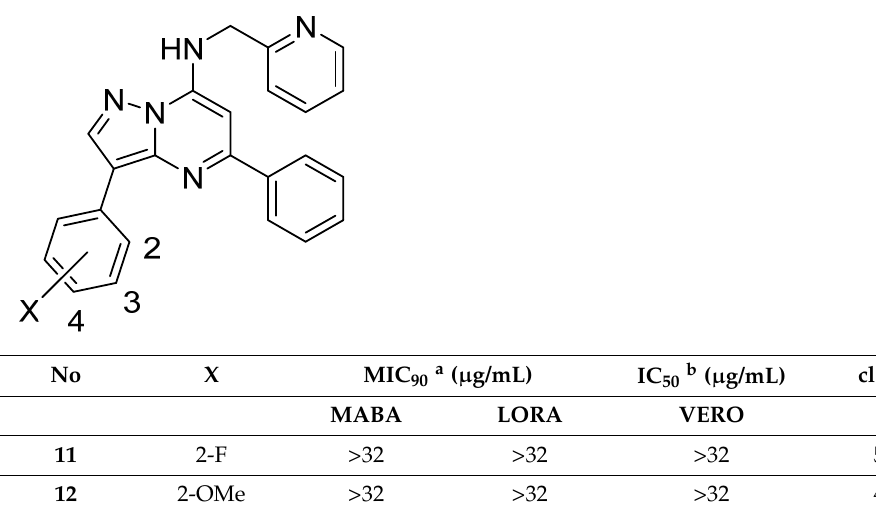
Table 1. Structures and biological data for 3-(phenyl-5-(substituted-phenyl)pyrazolo[1,5- a ]pyrimidine- 7-amines (compounds 11–21 ).